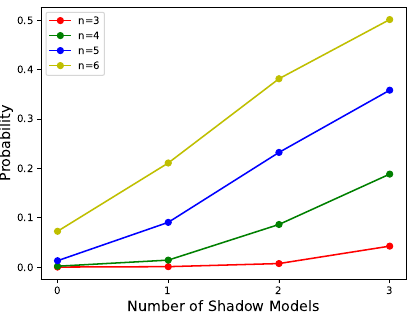
Figure 4. The relationship between P ( j (cid:62) k ) and number of shadow models with weight of 10 for different determined sharing states.